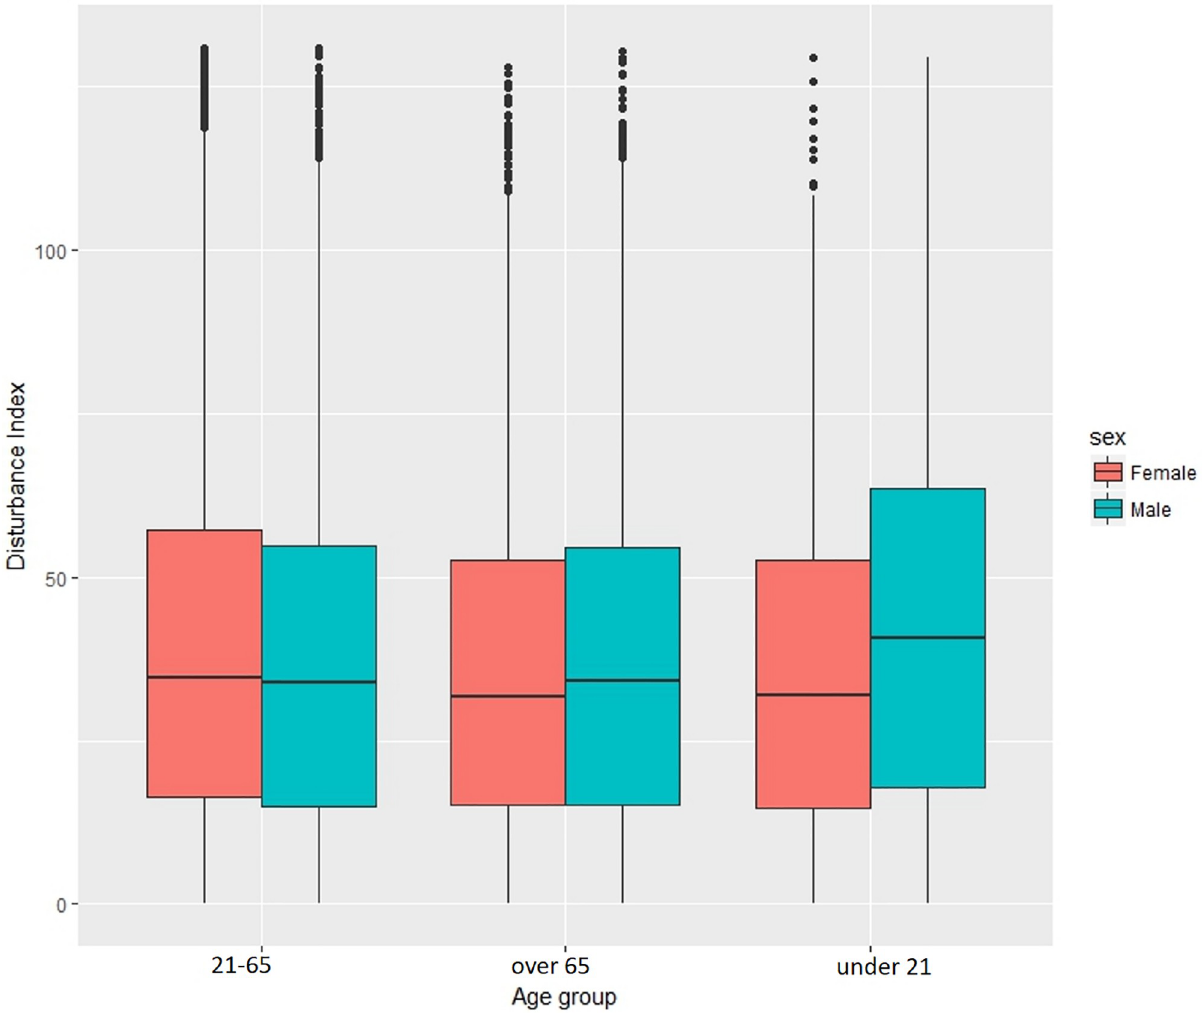
Fig 12. Individual disturbance for men and women in different age